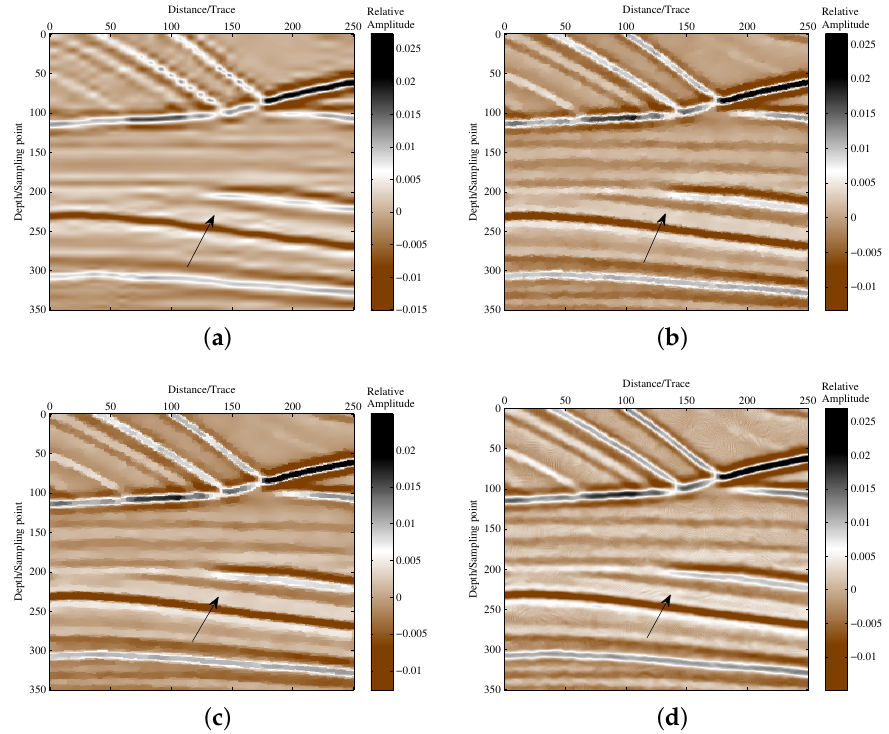
Figure 5. Denoising results of noisy seismic data with the SNR of 3 dB. ( a ) Wavelet denoising result, ( b ) ITVD result, ( c ) ATVD result and ( d ) SD-SpaLR